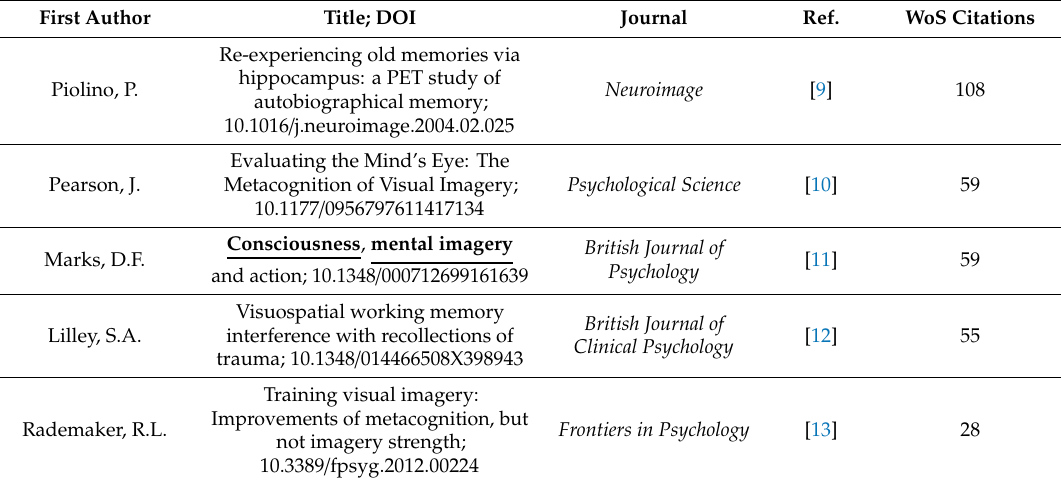
Table 1. Fifteen documents’ terms in title, abstract or keywords ordered by number of citations. Matches to search terms in the title are in bold and underscored.